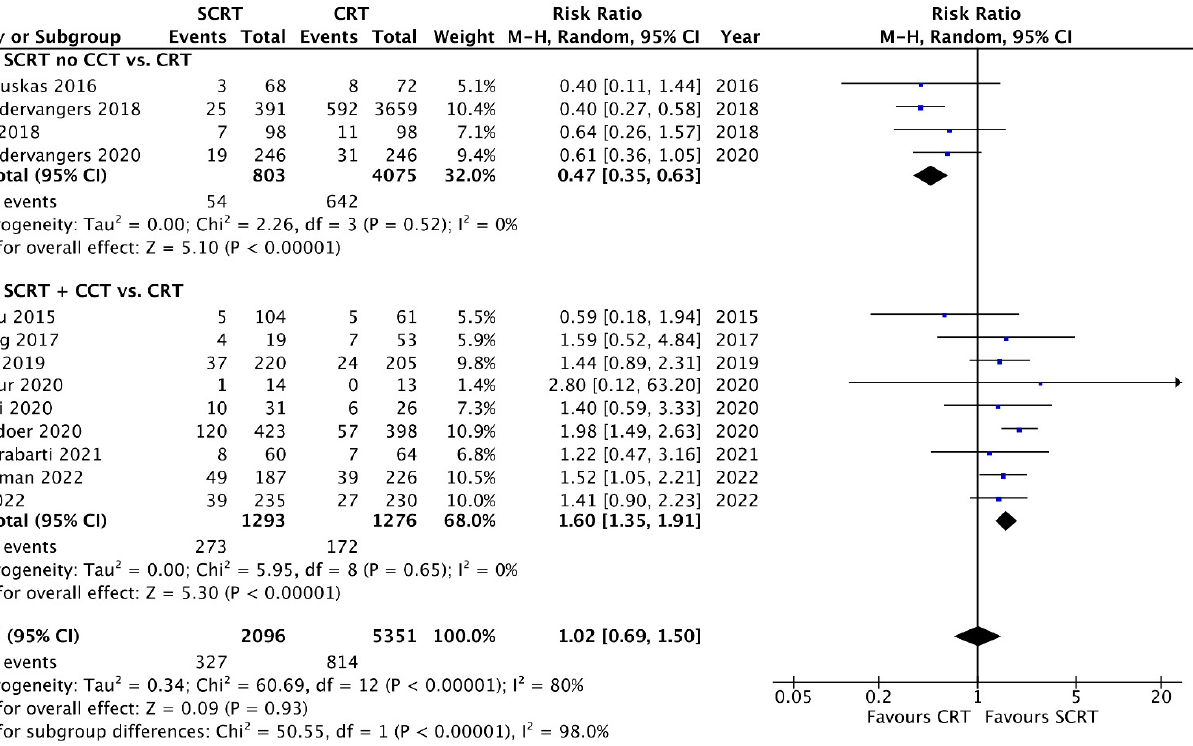
Figure 3. Forest plot of pathological complete response (pCR).